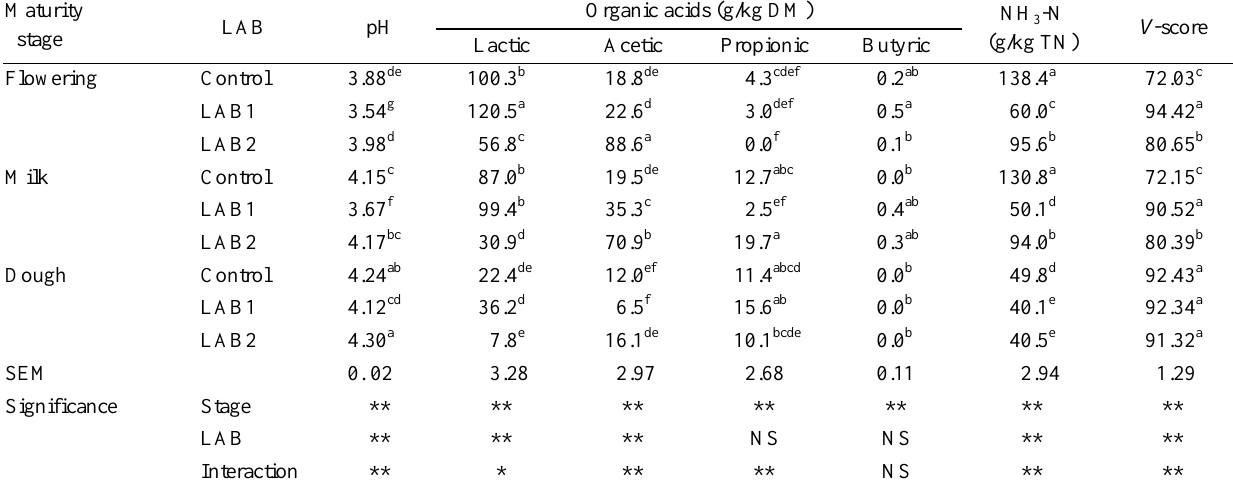
Table 3. Effects of maturity stage and LAB inoculants on the fermentation quality of wheat silage Maturity